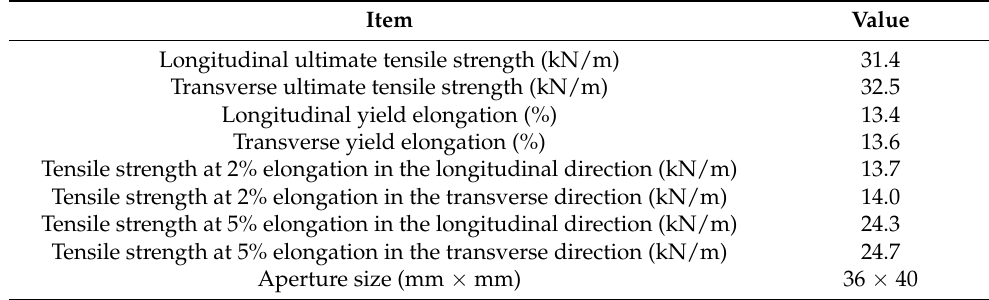
Figure 5. Soil grading curve. Table 1. Specific parameters of geogrid.